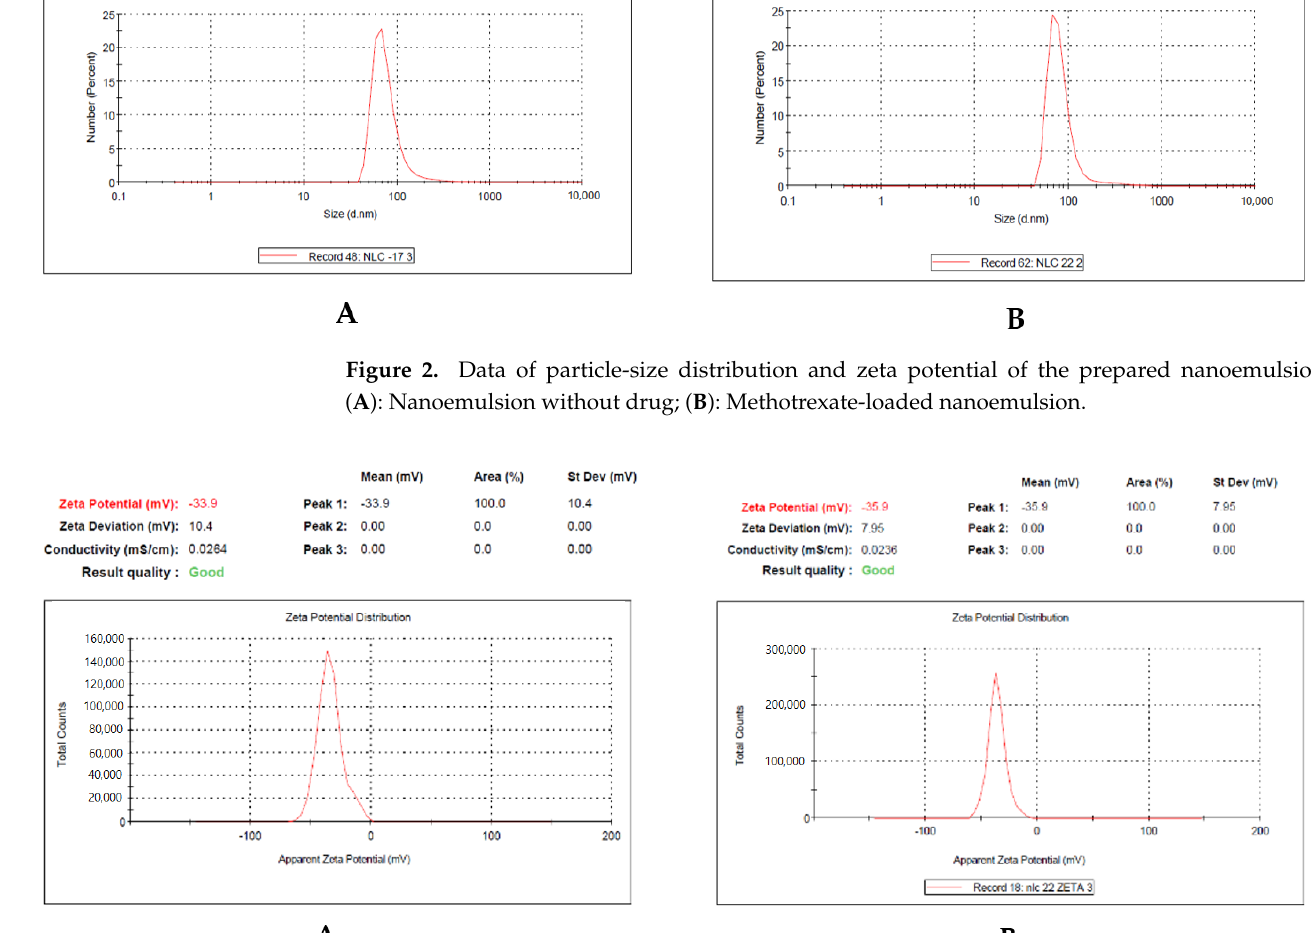
Figure 2. Data of particle-size distribution and zeta potential of the prepared nanoemulsion; ( A ): Nanoemulsion without drug; ( B ): Methotrexate-loaded nanoemulsion.